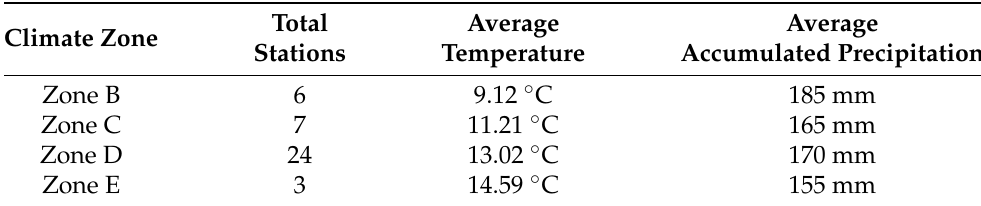
Table 3. Stations in the Region of Murcia by climatic zone and their most representative average climatic data.